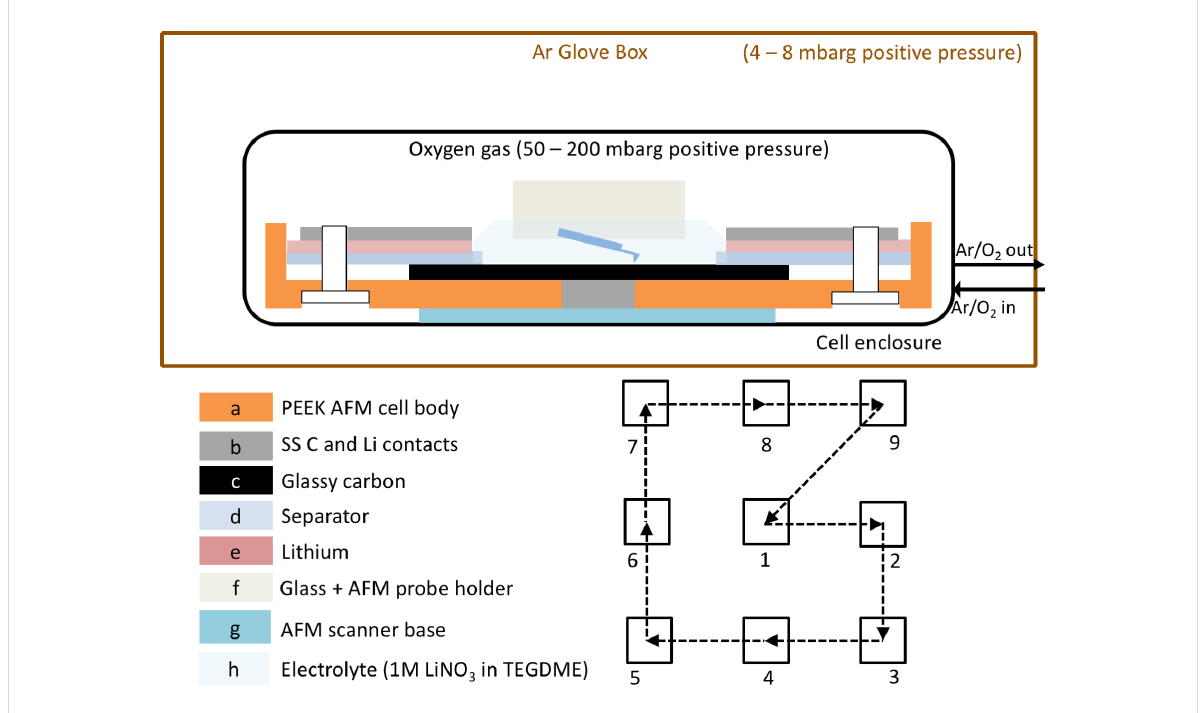
Figure 1: Schematic drawing of the AFM cell. Specially designed flanges on the sides of the glove box were used to accommodate all-metal gas feeds and electrical connections to the potentiostat and AFM controller. A spiral pattern (1–9) was devised to minimize the impact of tapping mode AFM scanning on the electrochemical deposits. This allowed every AFM line scan to be correlated with the electrochemical changes on the glassy carbon cathode surface.